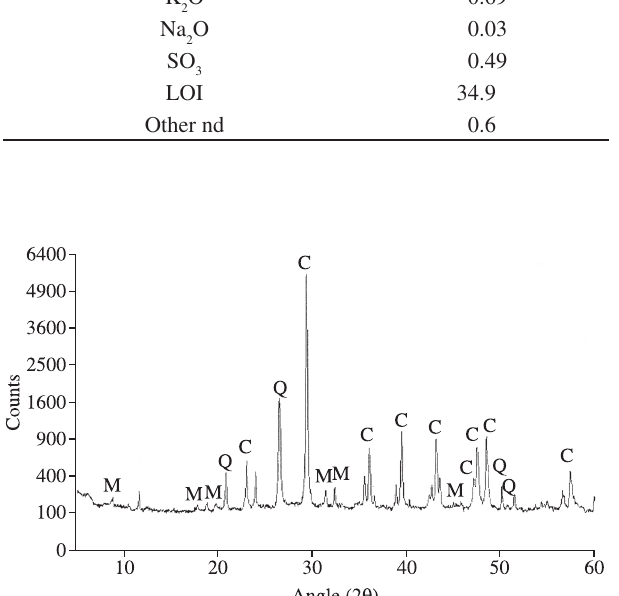
Figure 1. X-ray power diffraction of raw material.